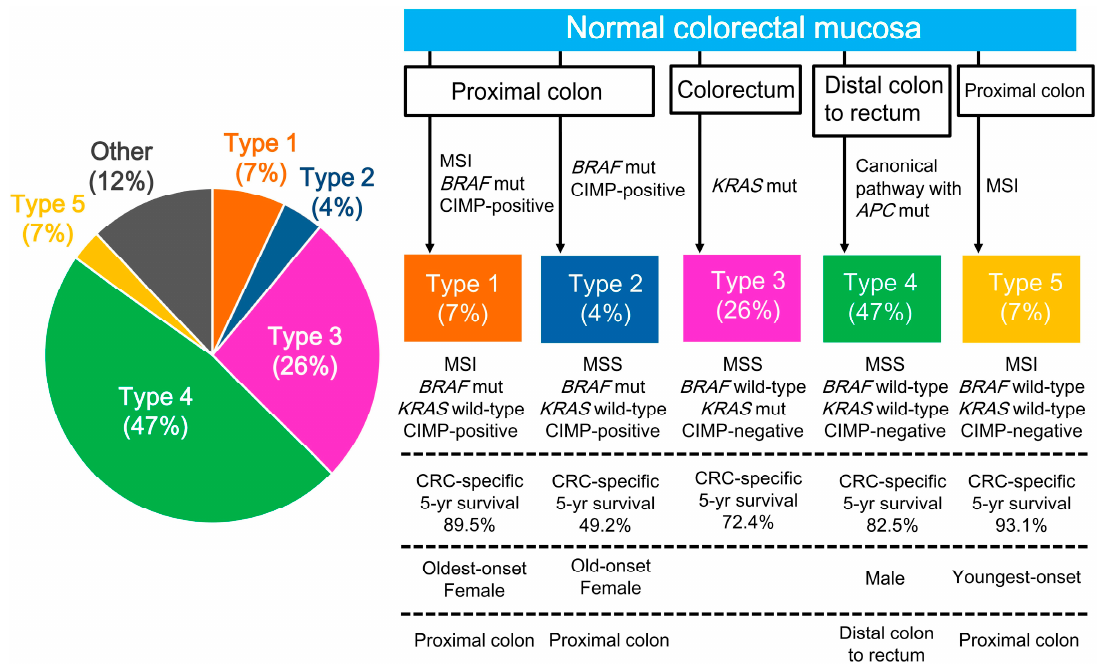
Figure 2. Categorization into five subtypes based on MSI and CIMP status and presence of BRAF and KRAS mutations [8]. CIMP, CpG island methylator phenotype; CIN, chromosomal instability; CMS, consensus molecular subtype; CRC, colorectal cancer; EMT, epithelial–mesenchymal transition; MSI, microsatellite instability; MSS, microsatellite stable; SCNA, somatic copy number alteration.